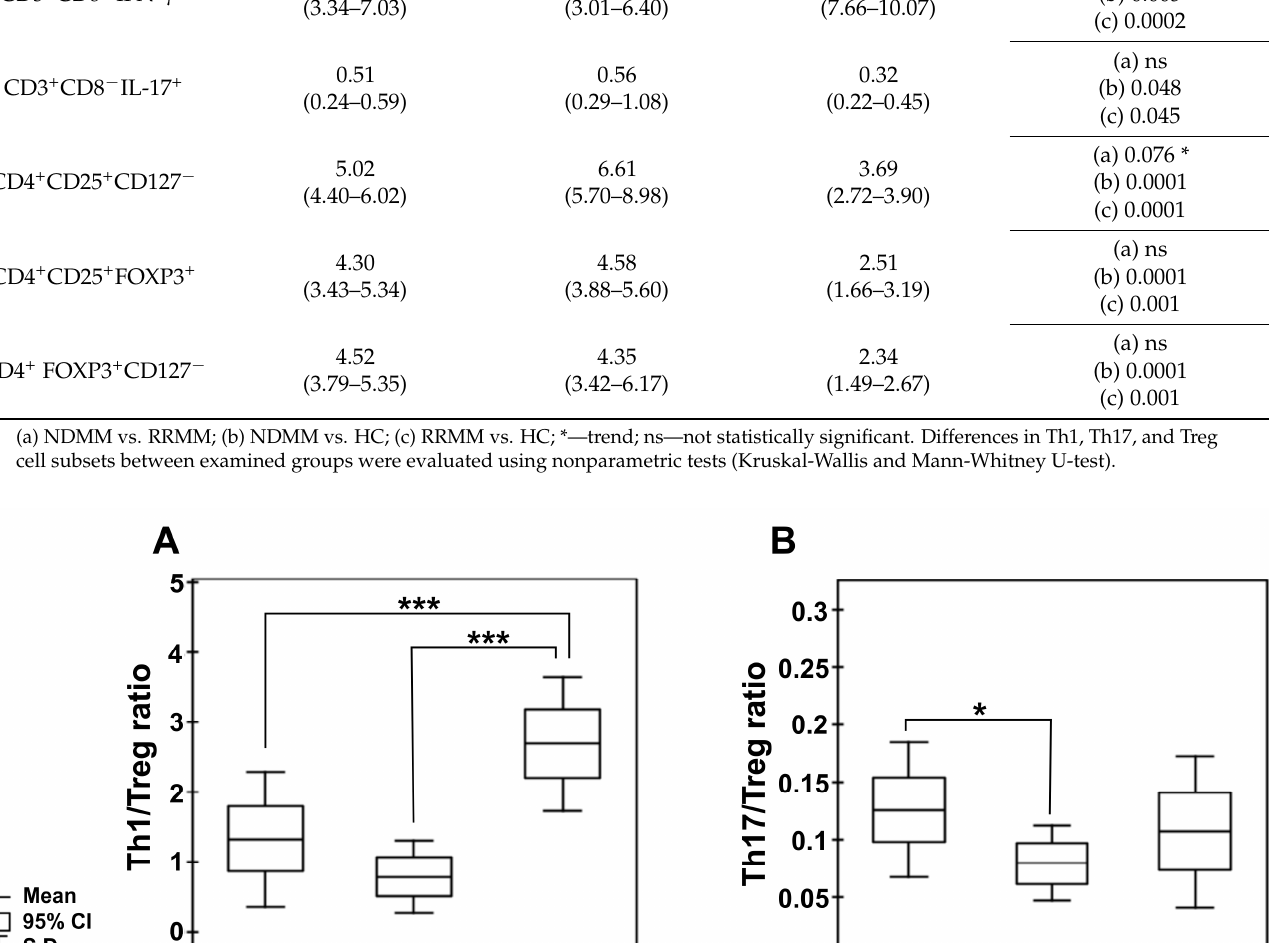
Figure 3. Peripheral blood Th1/Treg and Th17/Treg cell ratios in the different clinical phases of MM and healthy controls. ( A ) shows the ratio of the numbers of circulating IFN-secreting CD4 T cells (Th1) to regulatory CD4 + CD25+CD127 − T cells (Treg); ( B ) shows the ratio of circulating IL-17-secreting CD4 T cells (Th17) to regulatory CD4 + CD25 + CD127 − T cells. Boxes and whiskers show confidence interval and standard deviation (S.D.) respectively; the mean is the central square in each box. *** represents p < 0.001 and * represents p < 0.05.